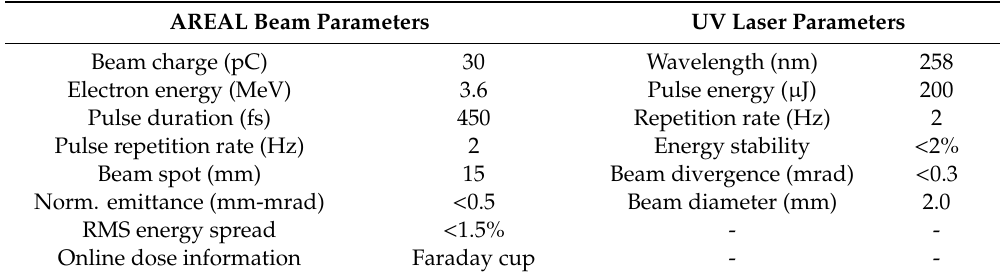
Table 1. Characterization of AREAL laser-generated electron